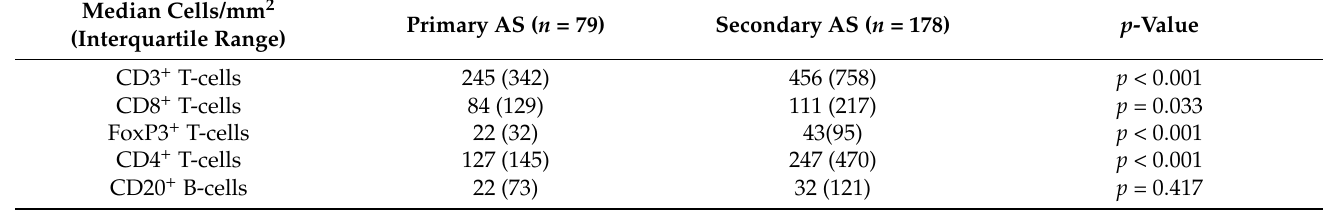
Table 2. Immune cell infiltrates are depicted for primary and secondary AS. Cell densities are reflected in cells/mm 2 with the interquartile range (IQR) for all individual immune cell subclasses.